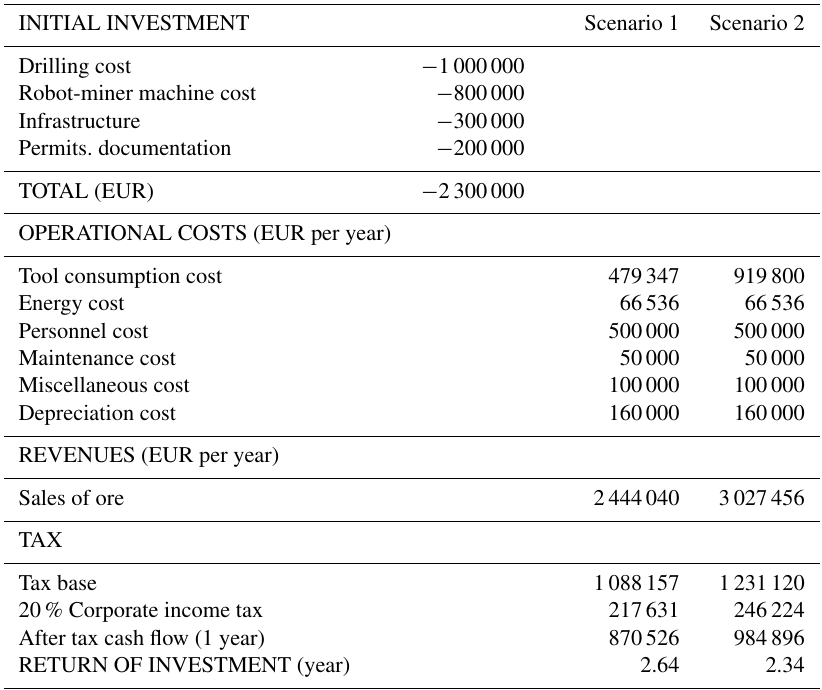
Table 1. A preliminary cost/revenues model f-or ROBOMINERS application using two scenarios: Scenario 1 – mining of copper ore from deep Kupfersciefer deposit, and Scenario 2 – mining of VMS deposit. Robot-miner parameters are assumed to be: power 35kW, excavation capacity 1m 3 /h and operational time